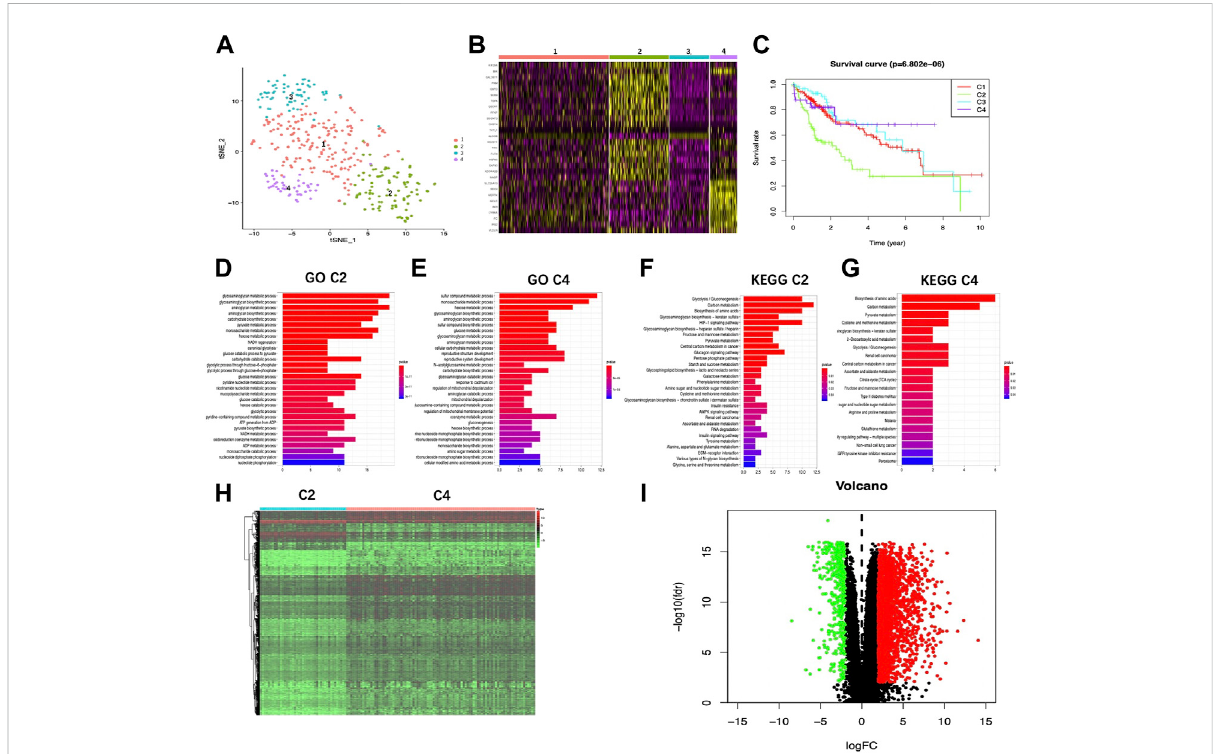
FIGURE 1 Glycolysis status and glycolysis associated DEG determination. (A) Dot plot showing the four different clusters distinguished using t-SNE algorithm based on 200 glycolysis-associated marker genes. (B) Heatmap showing the marker genes of the four clusters. (C) K-M plot showing patient OS in four clusters. (D,E) GO-BP terms enriched by marker genes of Cluster2 and Cluster4, respectively. (F,G) KEGG pathways enriched by marker genes of Cluster2 and Cluster4, respectively. Heatmap (H) as well as volcano plot (I) displaying the glycolysis associated DEGs in HCC compared with healthy samples. Red and green dots stand for DEGs with up-regulation and down-regulation, separately, whereas black dots indicate genes with no differential expression. T, tumor; N, normal